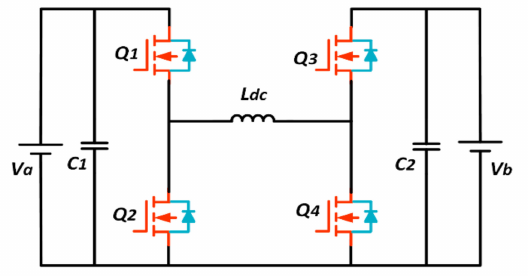
Figure 7. Cascaded bidirectional buck–boost converter [48].